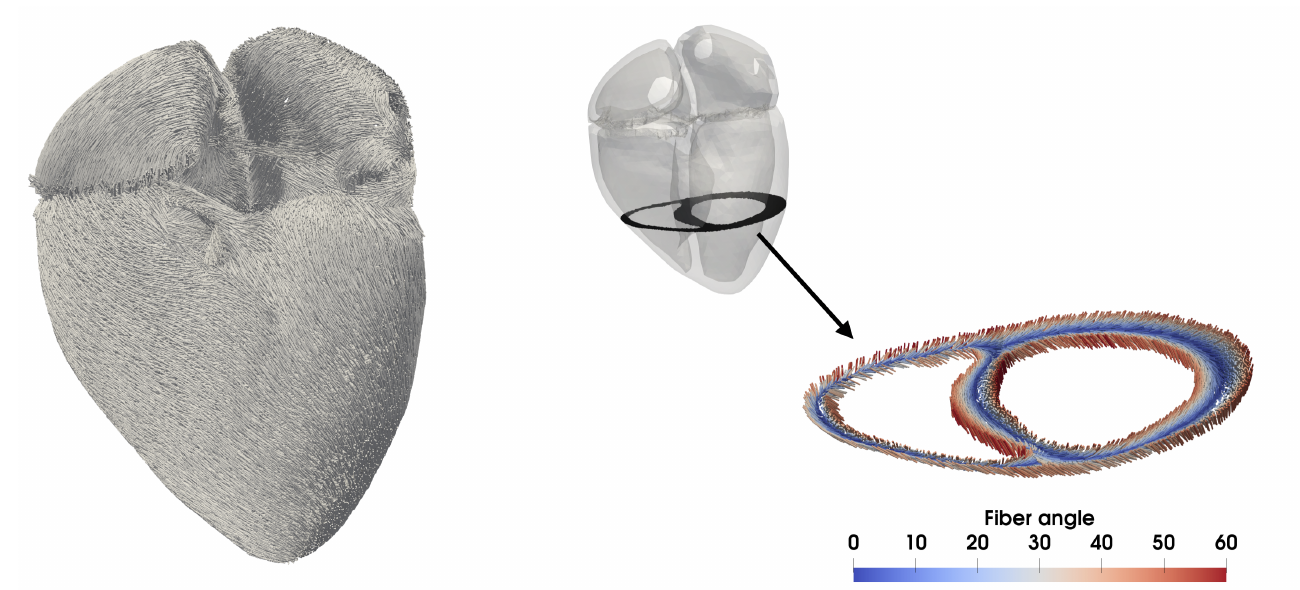
Figure 4. Myocyte orientation in the fiber direction f resulting from the algorithms in [58,106]. Fiber twist through the wall is shown in a slice through the ventricles.